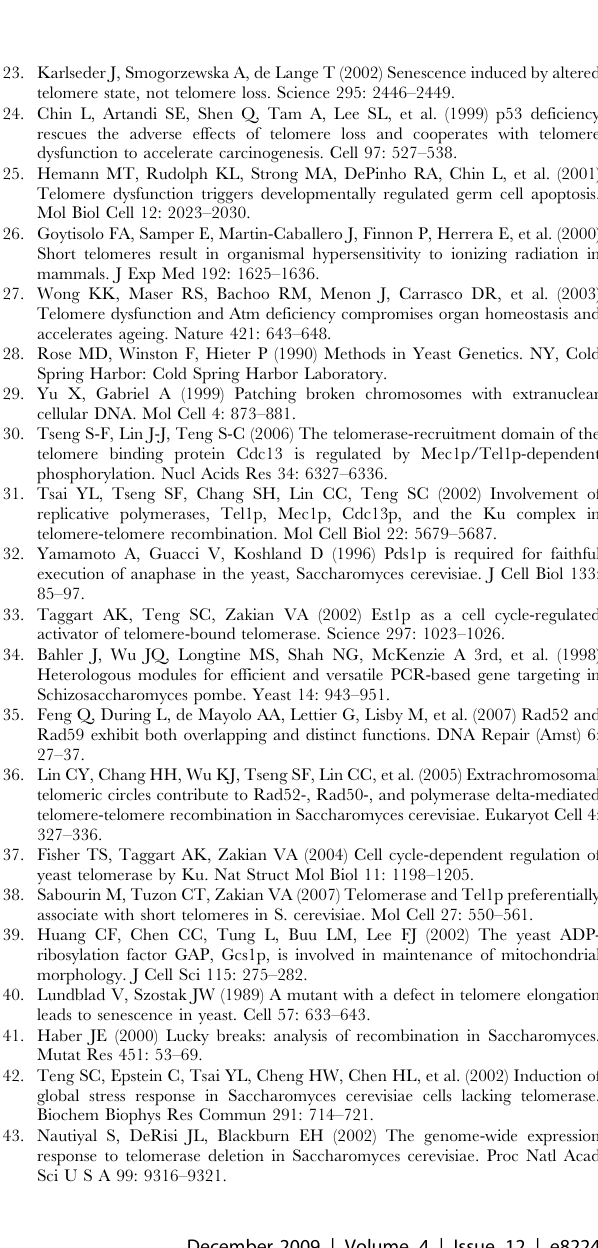
Table S1 Strains used in this study DOC) Table S2 Oligonucleotide